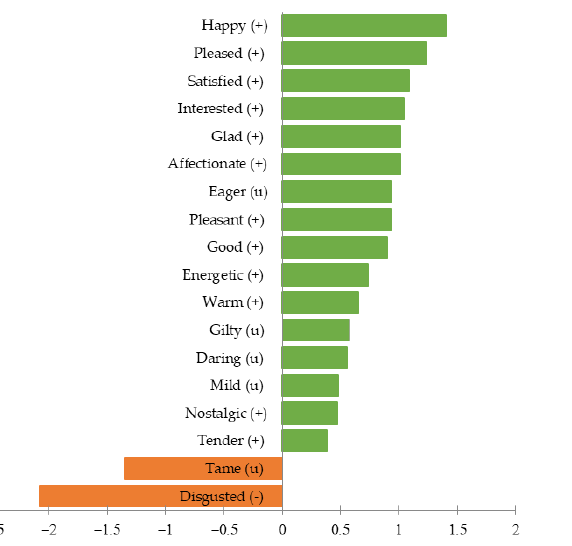
Figure 3. Effects on the mean for each significant attribute. Note: (+): positive emotion; ( − ): negative emotion; (u): neutral emotion.